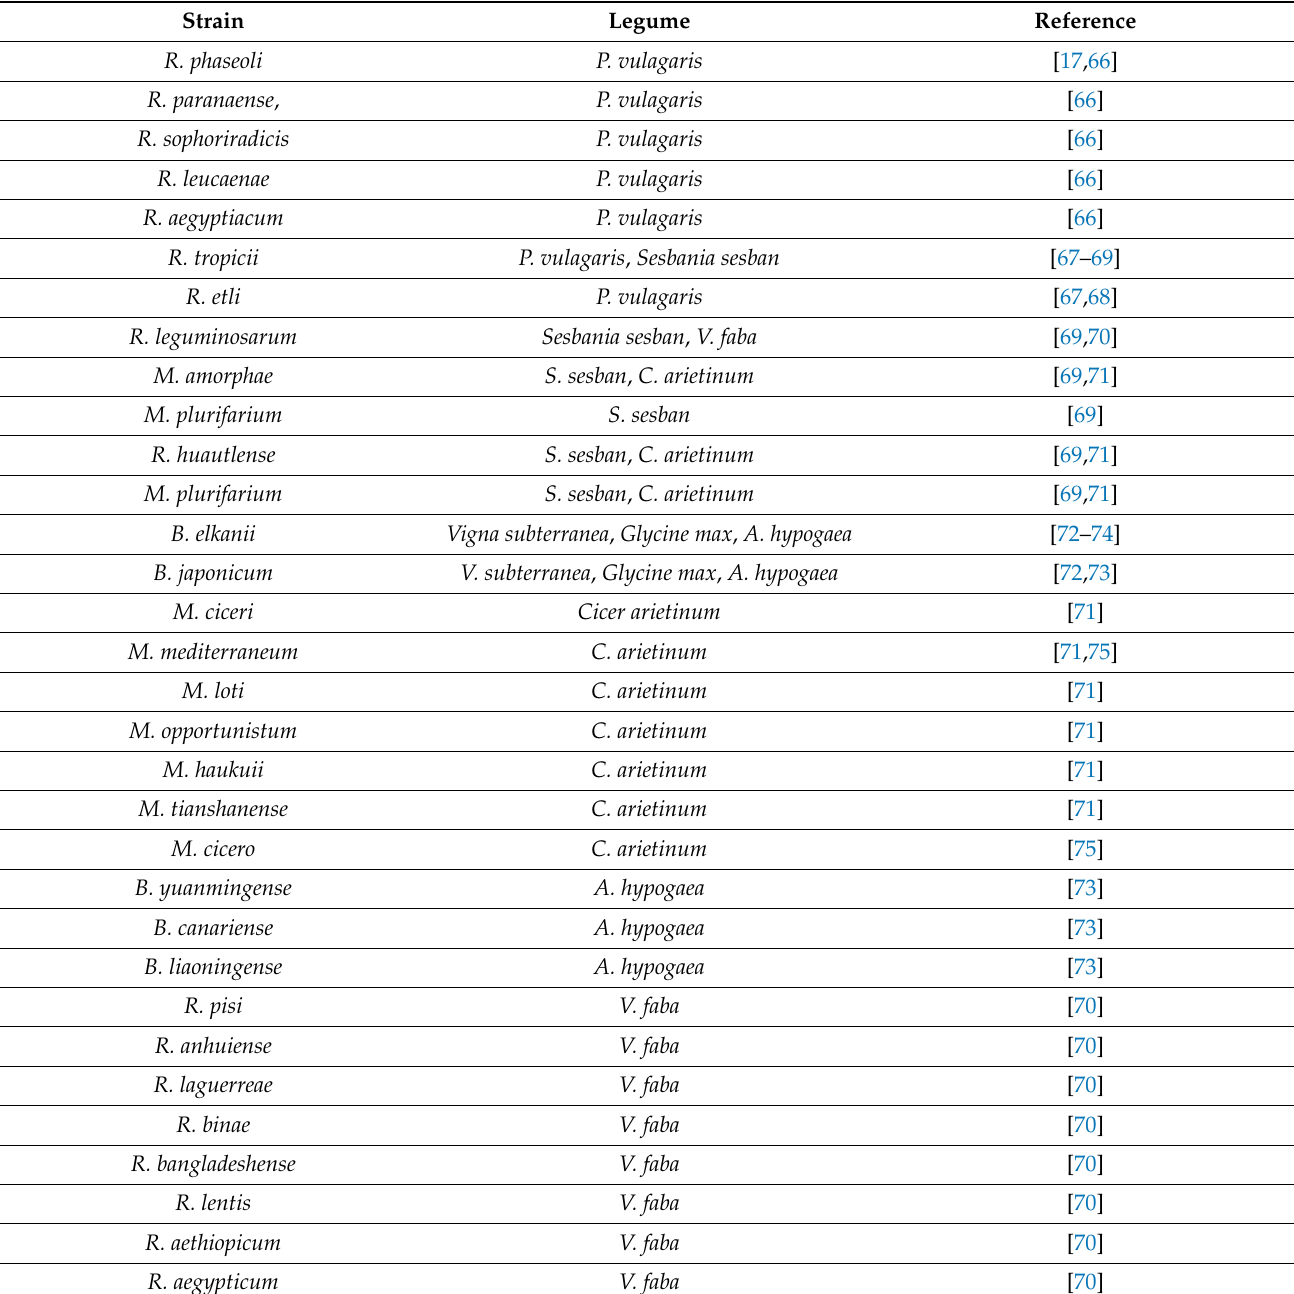
Table 1. Rhizobia isolated from African